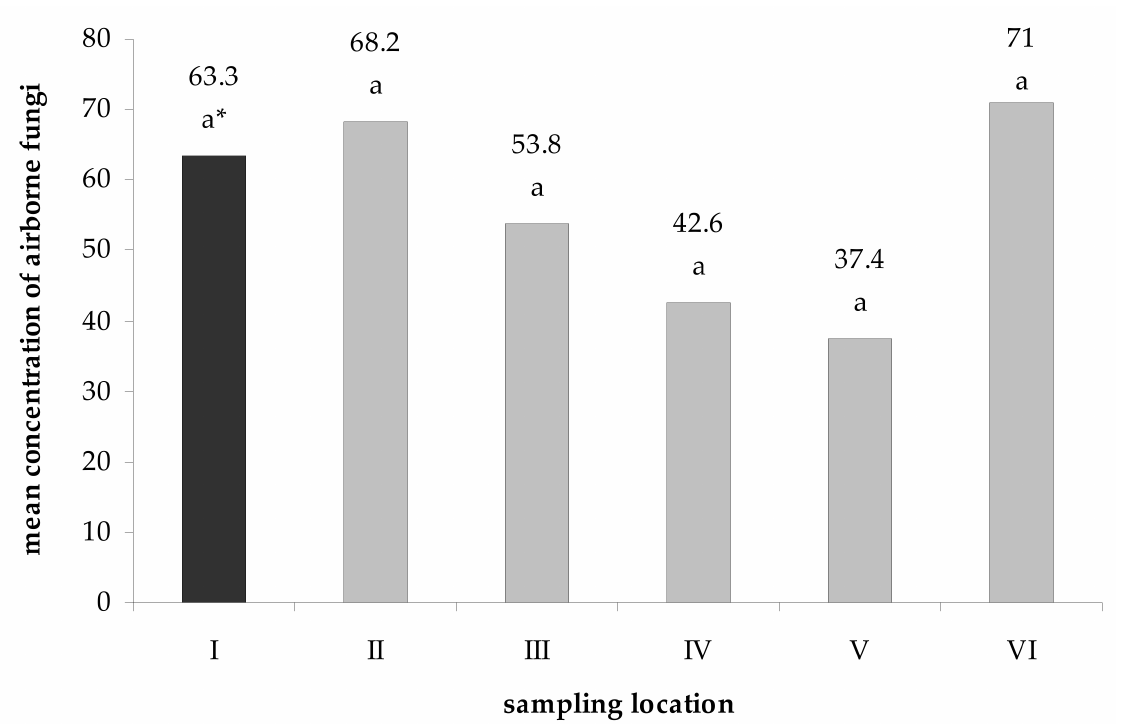
Figure 2. Mean concentration of airborne fungi (CFU per 1 m 3 ) cultured from the internal (I) and external air samples (II–VI) of the Brestovsk á Cave. * For each location, the number of fungal spores followed by the same letter are not statistically different, and others are (Tukey HSD test, α ≤ 0.05). Letters indicate the differences between fungal species in a given